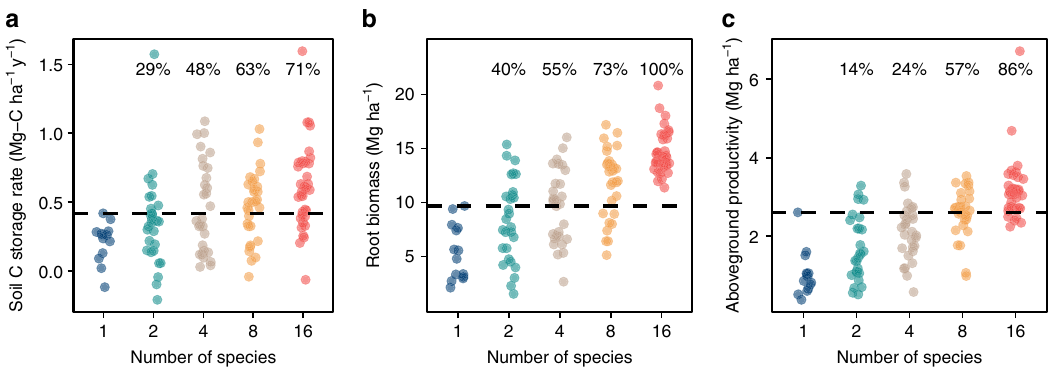
Fig. 3 Higher-diversity plots versus the best species in monoculture. a Soil C storage rate over the entire 22 years for the 0 – 60 cm soil pro fi le. b Mean root biomass for the 0 – 60 cm soil pro fi le (average of 2006, 2015, and 2017). c Mean productivity from 2012 to 2016. The numbers at the top of each panel are proportions of mixture plots surpassing the best performing monoculture species. Proportions increase with diversity for all three measures. Monocultures values are means of plots planted to a given